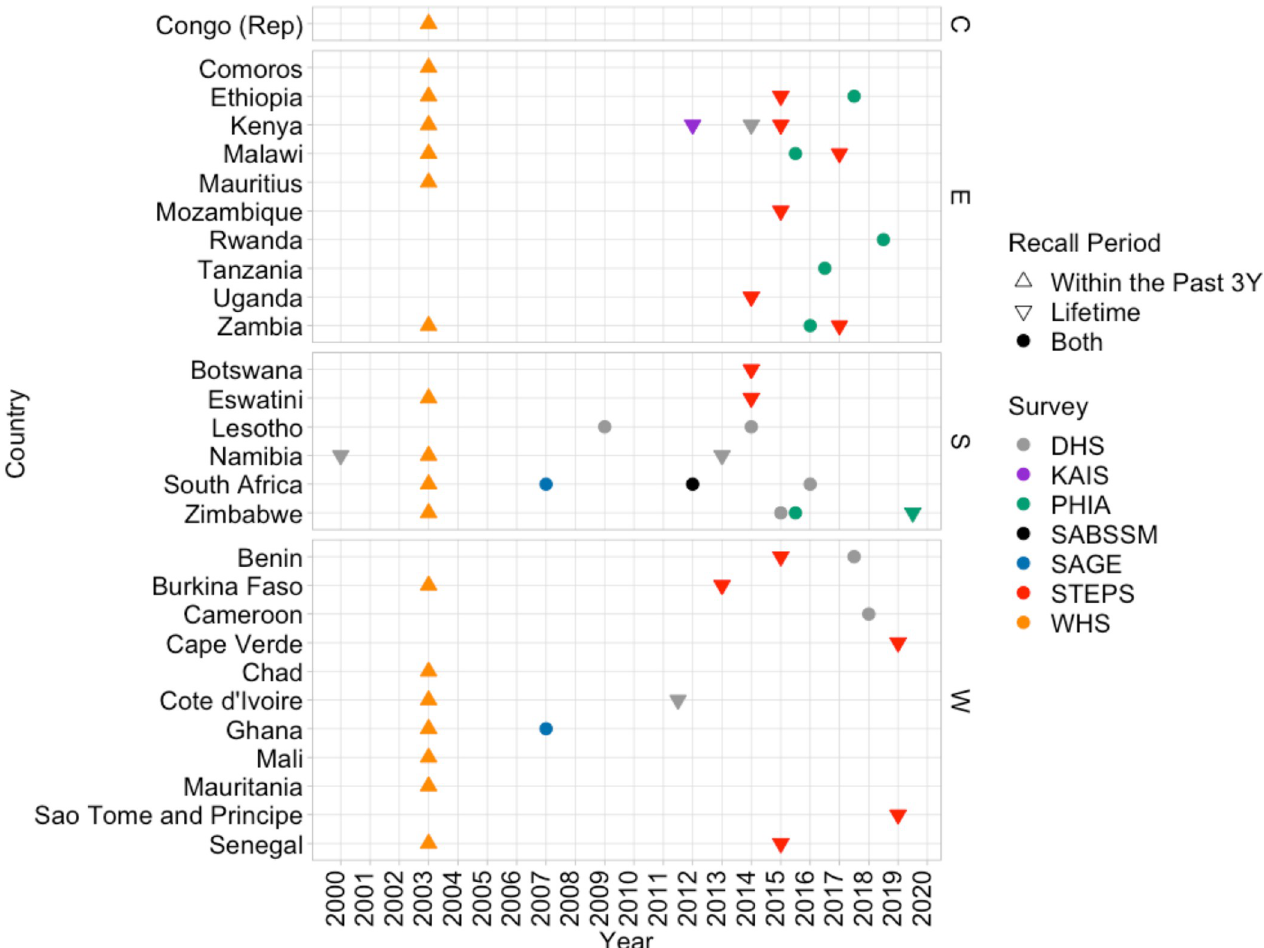
Fig 2. Survey data availability plots. Available surveys with information on cervical cancer screening by survey type, recall period, and region (C, Central Africa; E, Eastern Africa; S, Southern Africa; W, Western Africa). Colors represent survey type and shape represents recall period. (DHS, Demographic and Health Surveys ; KAIS, Kenya AIDS Indicator Survey ; PHIA, Population-based HIV Impact Assessment ; SABSMM, South Africa National HIV Prevalence , Incidence , Behavior and Communication Survey ; SAGE, Study on Global AGEing and Adult Health ; STEP, STEPwise Approach to NCD Risk Factor Surveillance ; WHS, World Health Surveys